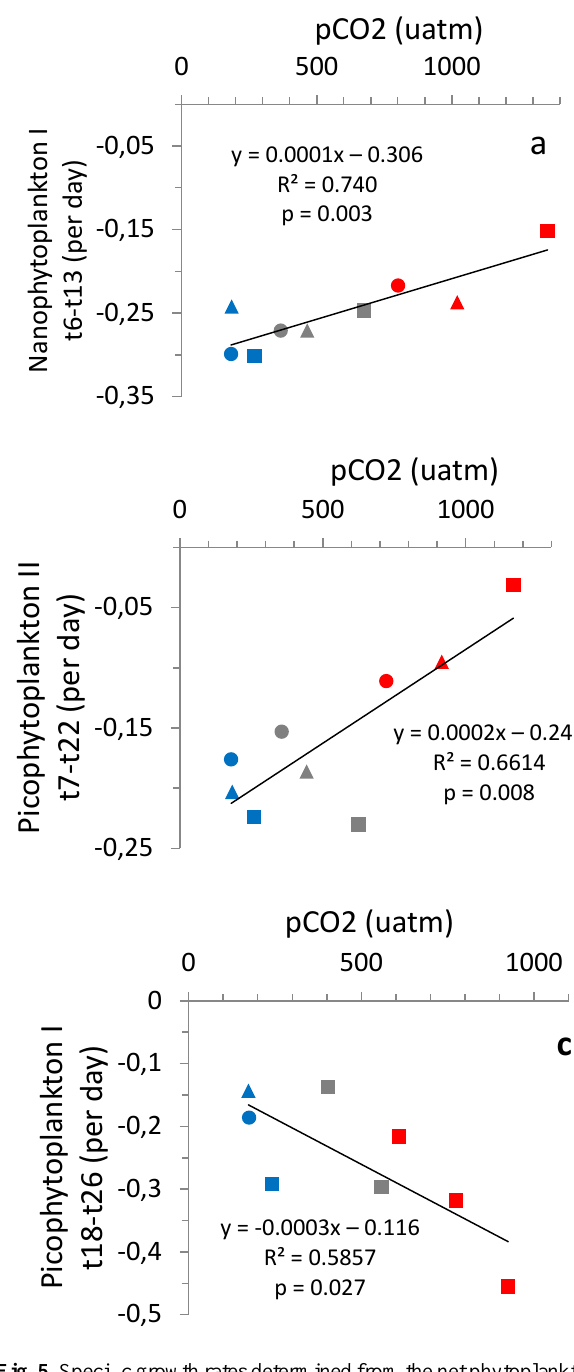
Fig. 5. Specific growth rates determined from the net phytoplankton abundances versus p CO 2 . Nanophytoplankton I from t 6– t 13 (a) , picophytoplankton II from t 7 to t 22 (b) , and picophytoplankton I from t 18– t 26 (c) . A negative growth rate indicates cell loss. The CO 2 concentrations plotted were the averages for the specific time periods indicated. For color and symbol coding, see Fig. 1. Linear regression statistics provided in